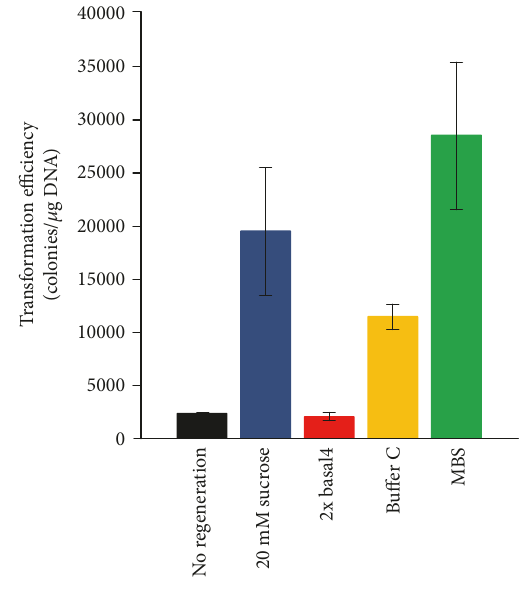
Figure 2: E ff ects of recovery conditions on transformation e ffi ciency. SK-1 cells harvested at early to midlog phase (OD =0.308) were transformed with 200 ng of pyrElacS800. 600 After electroporation (15 kV/cm, 9ms), the cell suspension was transferred to 800 μ L of recovery bu ff er (20 mM sucrose, 2 × basal4, Bu ff er C, and MBS) and incubated. Ten percent of the regenerated sample was mixed with 10 mL of top gel solution and poured onto XT plates by overlay cultivation. Error bars represent the standard deviation of three independent